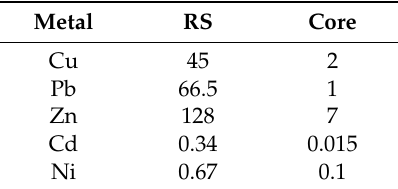
Table 3. Comparison of the maximum concentration of EDTA extracted metals (mg/kg) from the original RS and samples from the